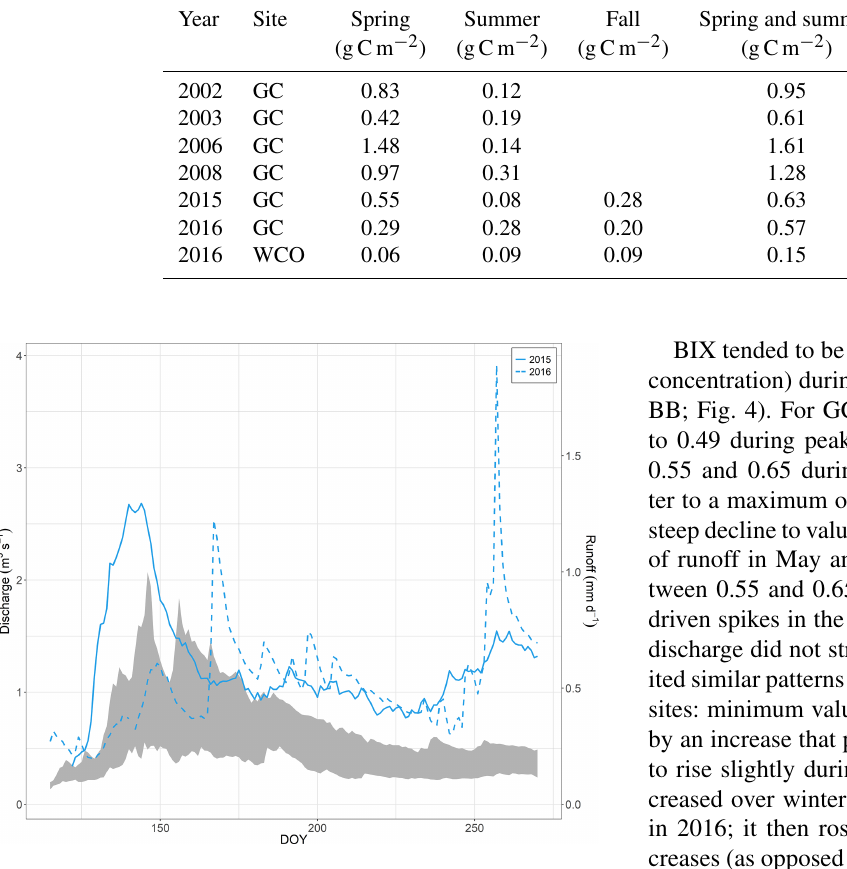
Figure 3. Historical flow at WCO with 2015–2016 flows superim- posed. The grey area represents the inter-quartile range of 1993– 2013 data. The solid line represents 2015, and the dashed line rep- resents 2016. The day of year (DOY) is shown along the x